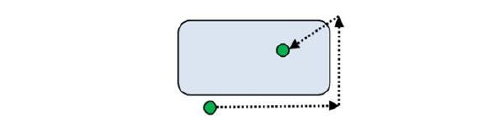
Figure 7. Jason’s first trip